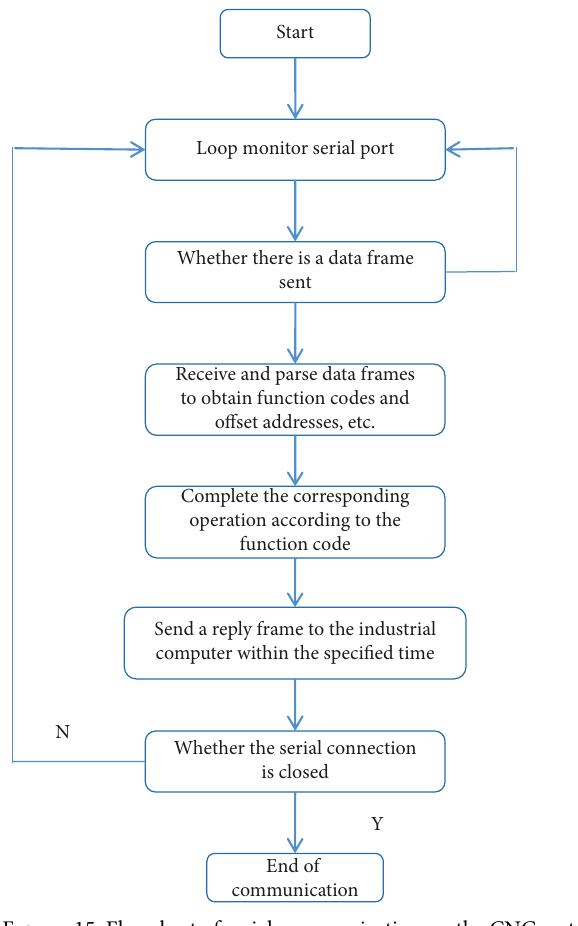
Figure 15: Flowchart of serial communication on the CNC system